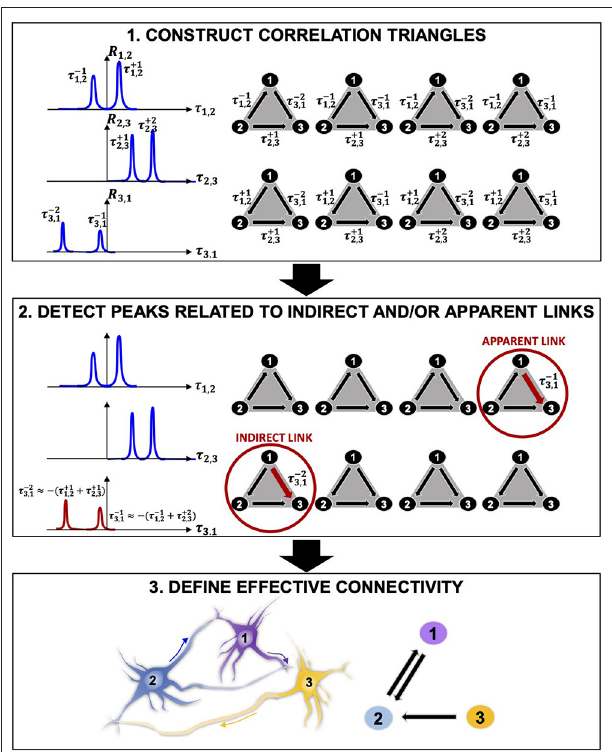
FIGURE 2 | Connectivity reconstruction via detection of correlation triangles and classification of indirect and apparent links. (1) Given three neurons 1, 2, and 3, our algorithm searches, in time, for all correlations between them by computing the pairwise correlation functions R 1,2 , R 2,3 , and R 3,1 . In this representative example, the algorithm detects two correlation peaks for each pair of neurons and associates the corresponding delays of interactions ( τ − 1 1,2 ,